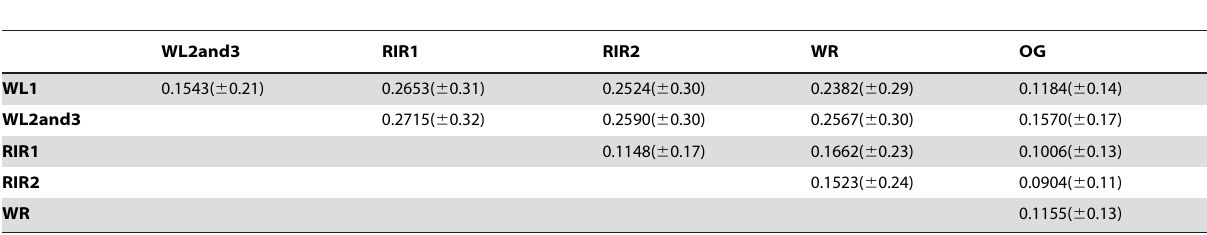
Table 3. Average F ST values with standard deviation over all SNPs for all